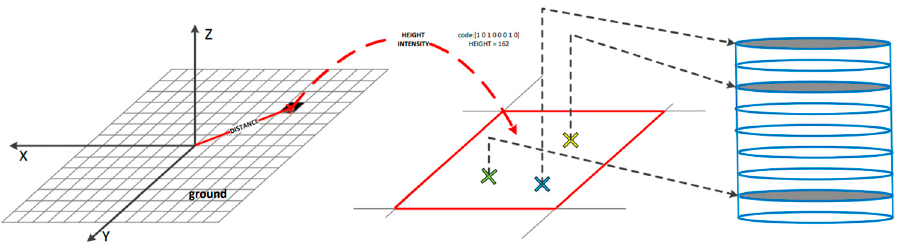
Figure 3. A visual illustration of the CMCD coding process: each channel corresponds to distance, intensity, and height information, respectively.